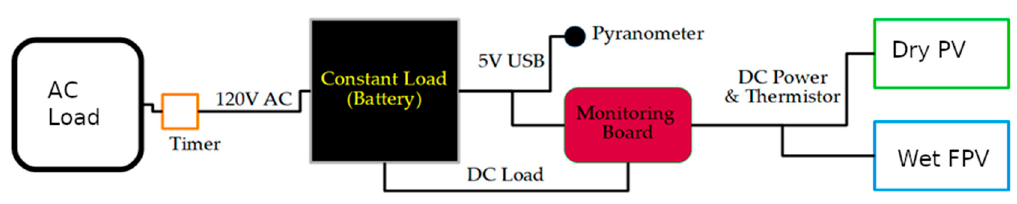
Figure 2. Closeup of floating photovoltaic/floatovoltaic (FPV) corner after deployment, showing water coverage from a modest wave (top left).